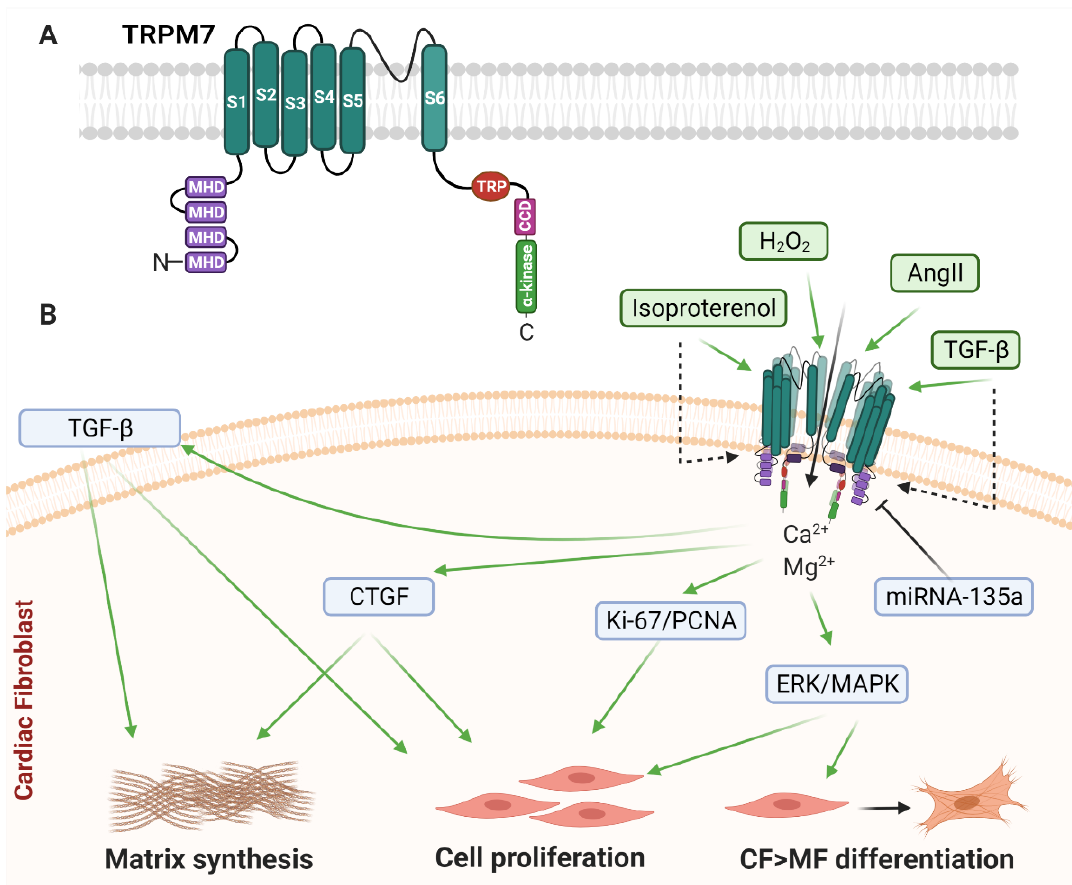
Figure 3. Schematic diagram of TRPM7 structure and cardiac fibroblast signalling. ( A ) Basic structure of alpha subunit of TRPM7. Each TRPM7 alpha subunit is comprised of six transmembrane-spanning domains (S1–S6), with a pore loop between S5 and S6, melastatin homology domains (MHD) at the amino termini, and a TRP-box (TRP), a coiled-coil domain (CCD), and an atypical α -type serine/threonine protein kinase domain ( α -kinase) at the carboxyl termini. ( B ) Known TRPM7 homotetrameric ion channel signalling in cardiac fibroblasts. Ang II drives activation of TRPM7 and is coupled to increased nuclear activity of Ki-67 and proliferating cell nuclear antigen (PCNA), as well as upregulation of markers of fibrosis including connective tissue growth factor (CTGF). H 2 O 2 activates TRPM7 and promotes MF differentiation and ECM remodelling via the ERK-1/2 MAP kinase pathway. TGF- β 1 and isoproterenol treatment both induce upregulation of TRPM7 expression and Ca 2+ influx leading to myofibroblast differentiation. TRPM7 expression can be inhibited by miR-135a expression. See main text for details.